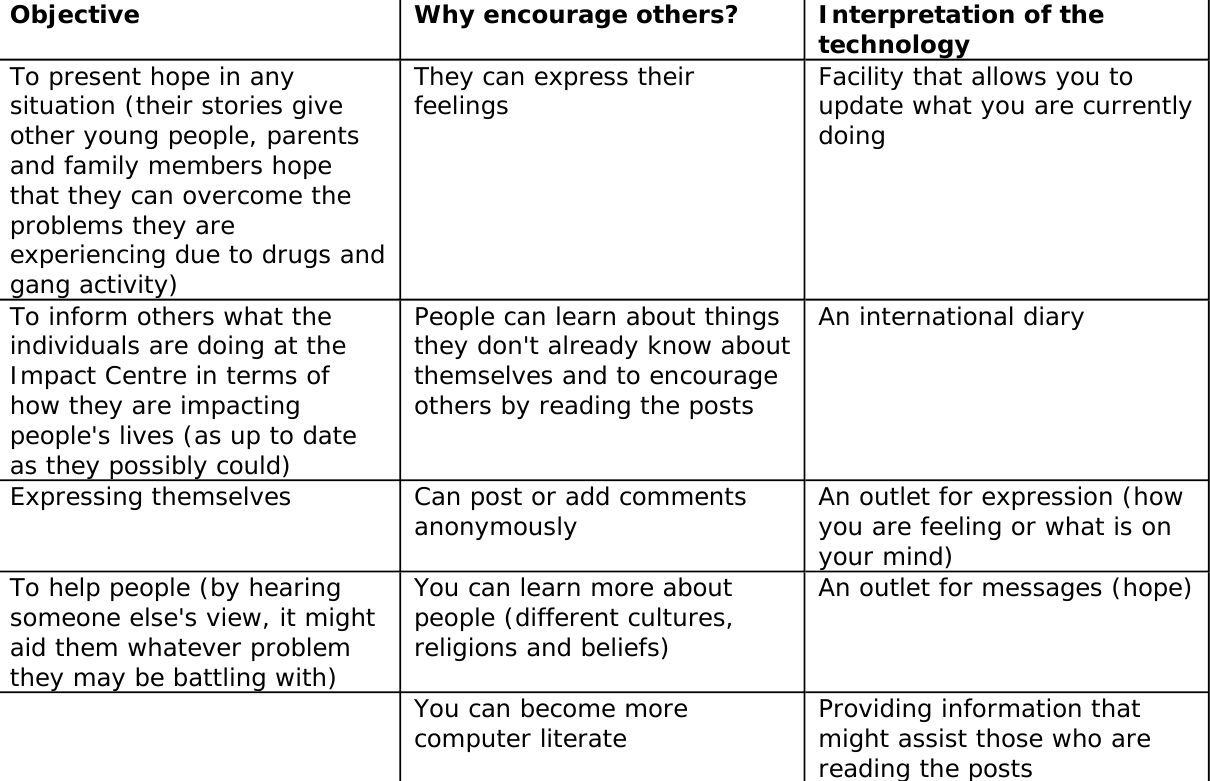
Table 2 Summary of the response to the